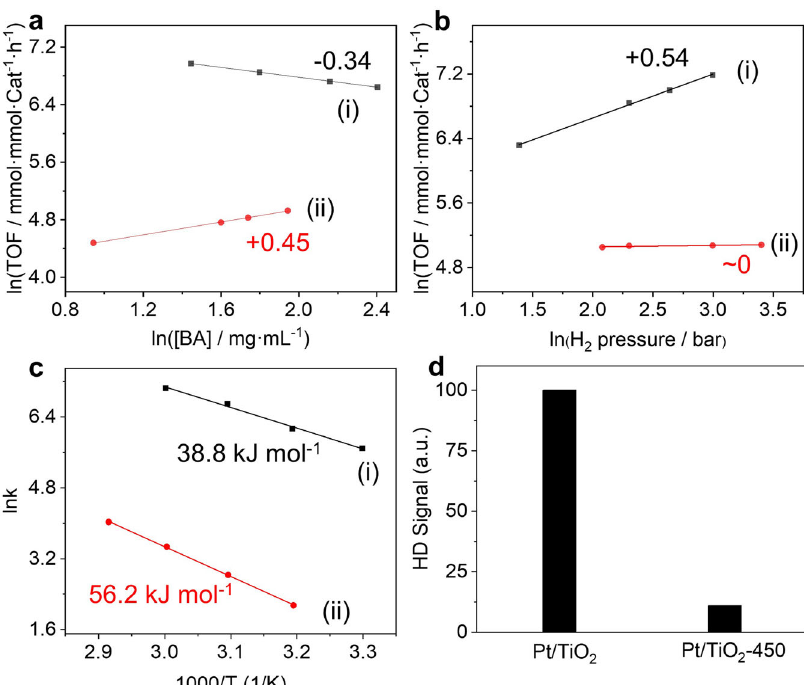
Fig. 3 Kinetic results and H 2 -D 2 exchange results on Pt/TiO 2 and Pt/TiO 2 -450. Reaction orders with respect to a BA and b H 2 , c Arrhenius plots showing apparent activation barriers, and d H 2 -D 2 exchange results of ( i ) Pt/TiO 2 and ( ii ) Pt/TiO 2 -450. Reaction conditions for ( a ) and ( b ): 60 °C, 3 mL n- hexane, H 2 pressure: 1 – 30 bar, BA concentration: ~3 – 10 mg mL − 1 . Reaction conditions for ( c ): T = 30 – 70 °C, S/C = 250, 3 mL hexane. The BA conversion was maintained ~10 – 20% by adjusting reaction time. TOF turnover frequency, BA benzoic